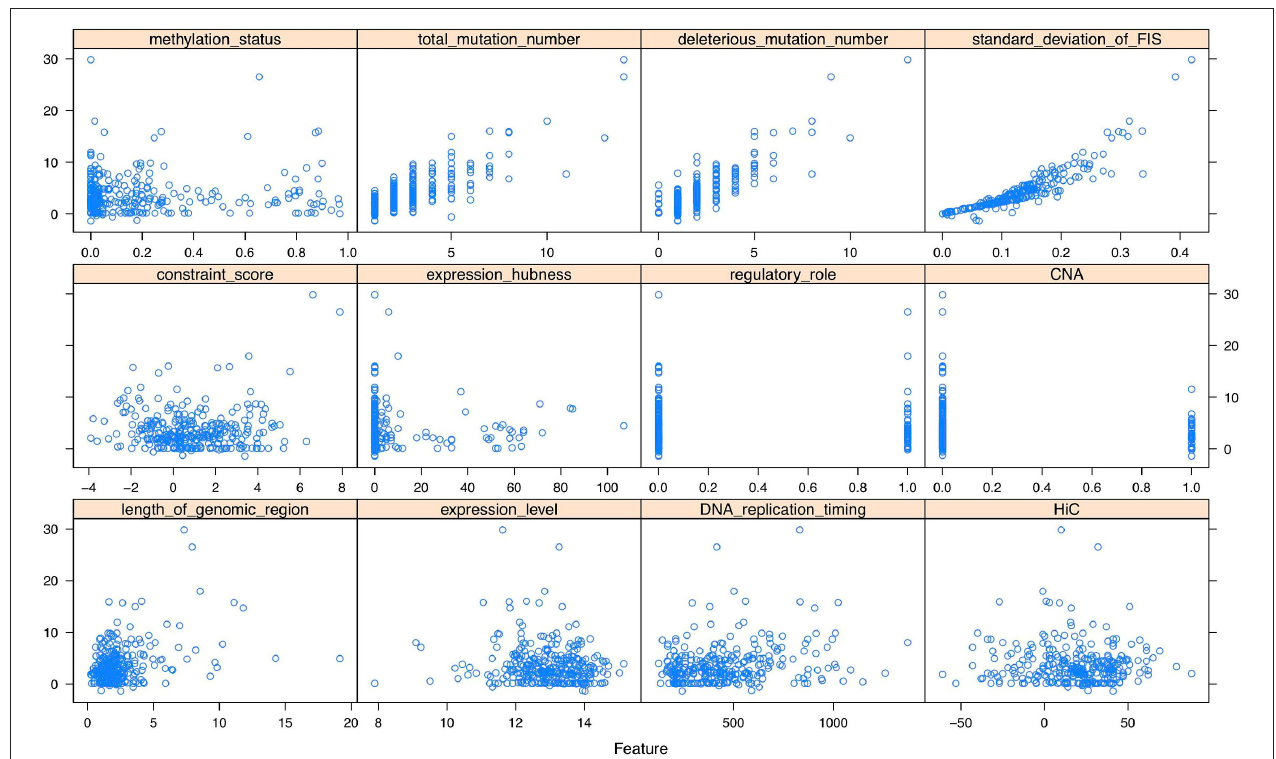
FIGURE 2 | The scatter plots between functional impact score (FIS) and multi-omics features of 300 genes (randomly sampling) in breast invasive carcinoma (BRCA).